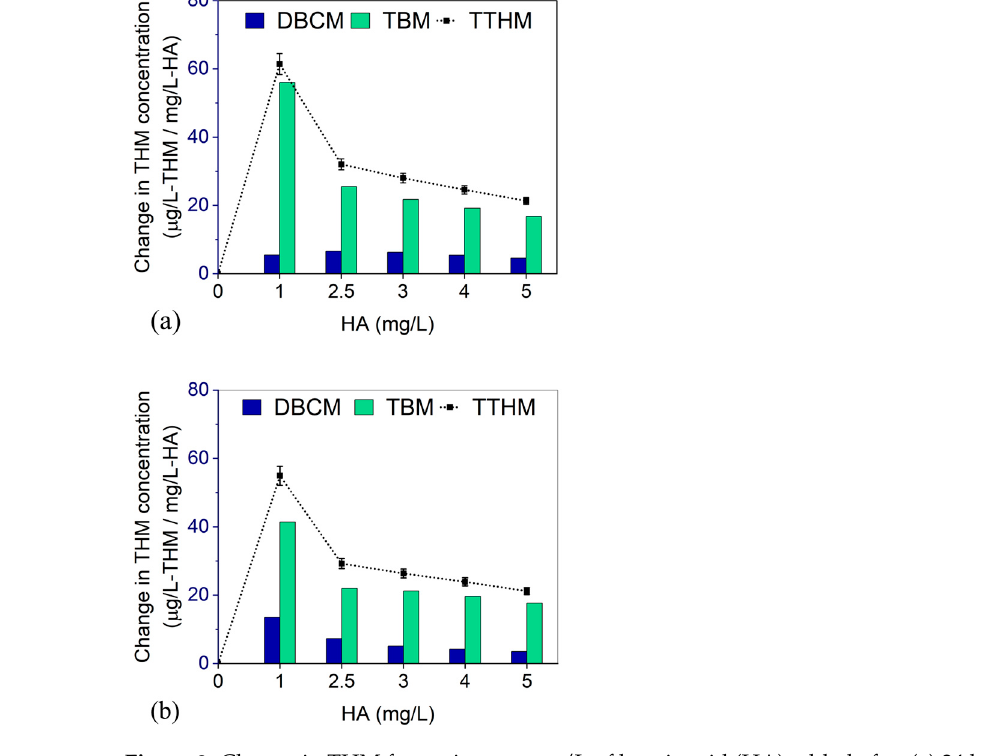
Figure 3. Change in THM formation per mg/L of humic acid (HA) added after ( a ) 24 h and ( b ) 48 h (SWI = 1%).